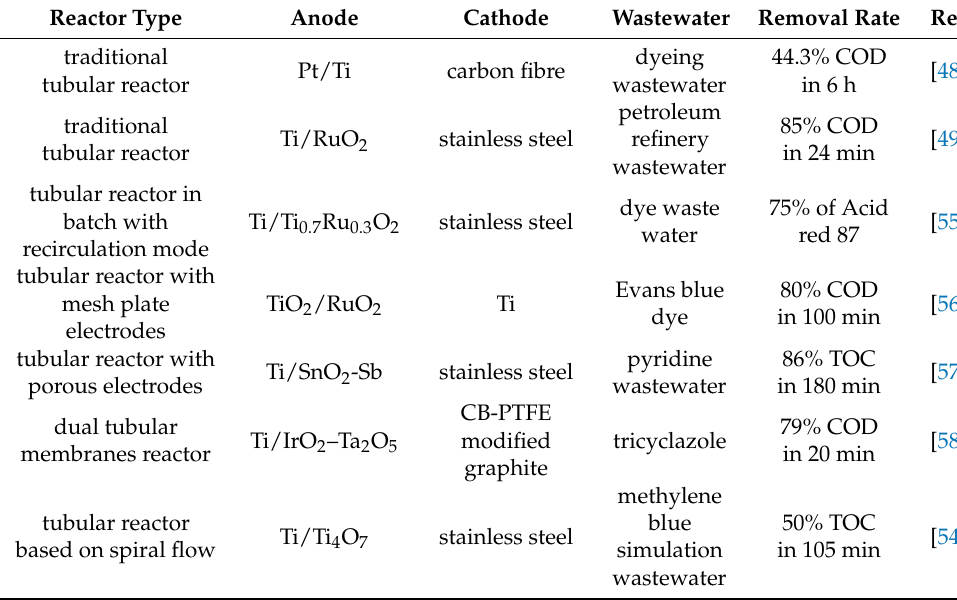
Table 2. Treatment of different organic wastewater by tubular